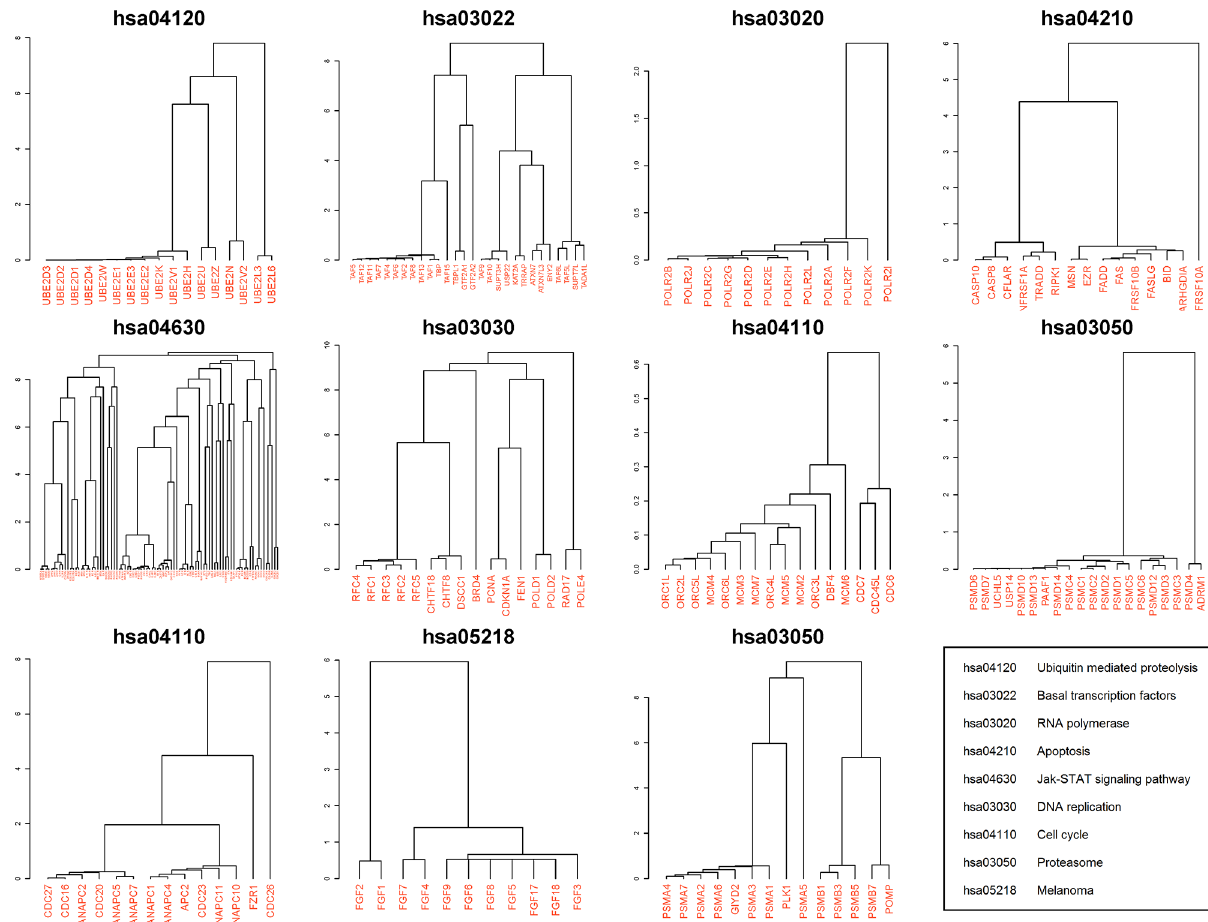
Fig 4. Subclusters significantly enriched in KEGG pathways with p-value < 10 − 20 . The left bar in each plot shows the height of the subcluster in the whole cluster of 2,698 proteins. The name above each plot is the KEGG pathway ID corresponding to the most significant p-value. The bottom right panel maps the pathway IDs to the pathway